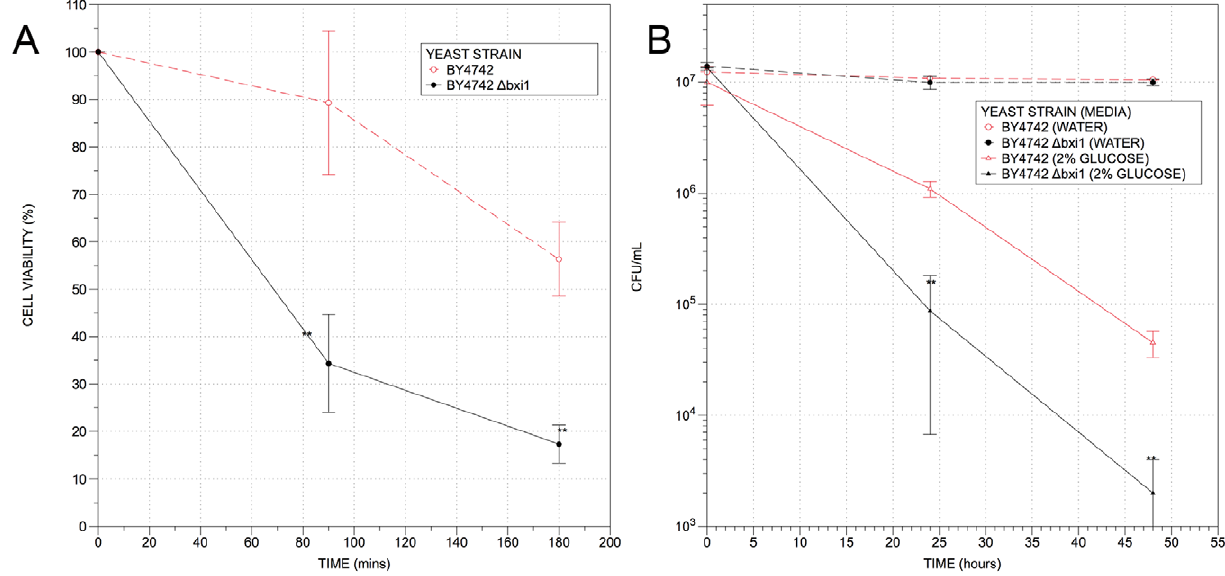
Figure 3. Yeast cells lacking BXI1 are more susceptible to ethanol-induced and glucose-induced programmed cell death. Wildtype and D bxi1 cells from the BY4742 strain background were cultured in rich YPD media overnight and resuspended in fresh media and allowed to reach exponential phase (an approximate OD 600 value of 0.4). (A) Exponential growing yeast cells were then resuspended in fresh media or in fresh media containing 22% ethanol, allowed to grow at 30 u C for the indicated times, serially diluted onto YPD plates, and cultured at 30 u C for 2 days. (B) Exponential growing yeast cells were then resuspended in water or in 2% glucose, allowed to grow at 30 u C for the indicated times, serially diluted onto YPD plates, and cultured at 30 u C for 2 days. The differences in viabilities were deemed statistically significant by the Student’s t-test (p , 0.05). Error bars indicate standard deviations for trials with at least three independent cultures.